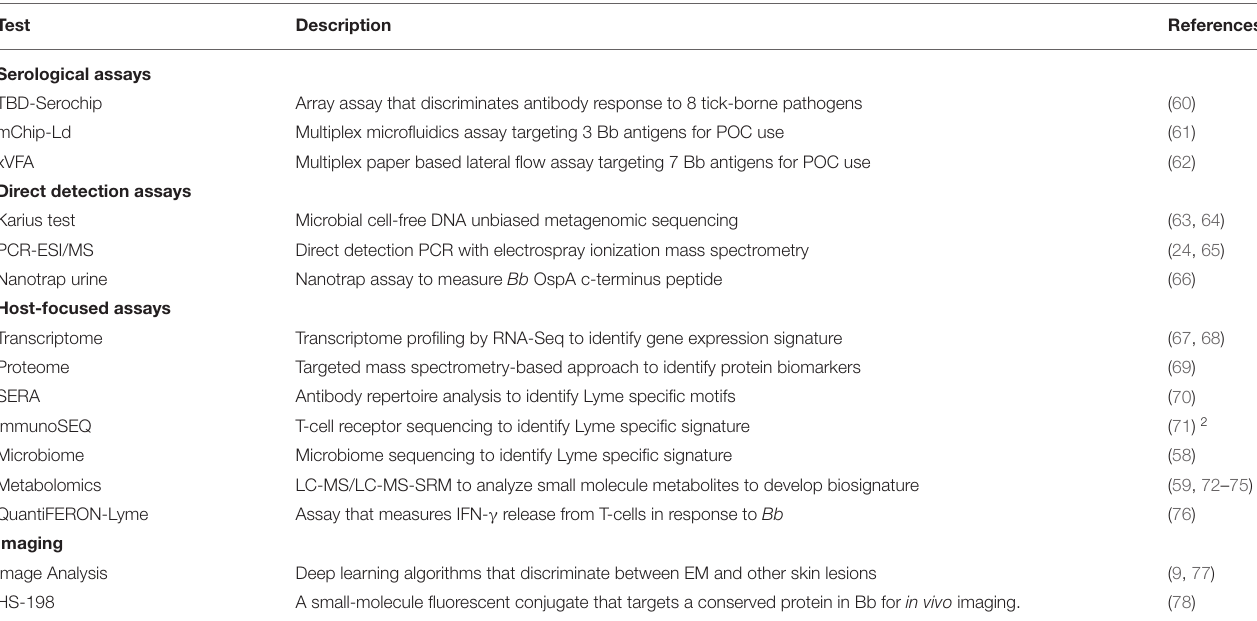
TABLE 2 | Emerging diagnostic assays for